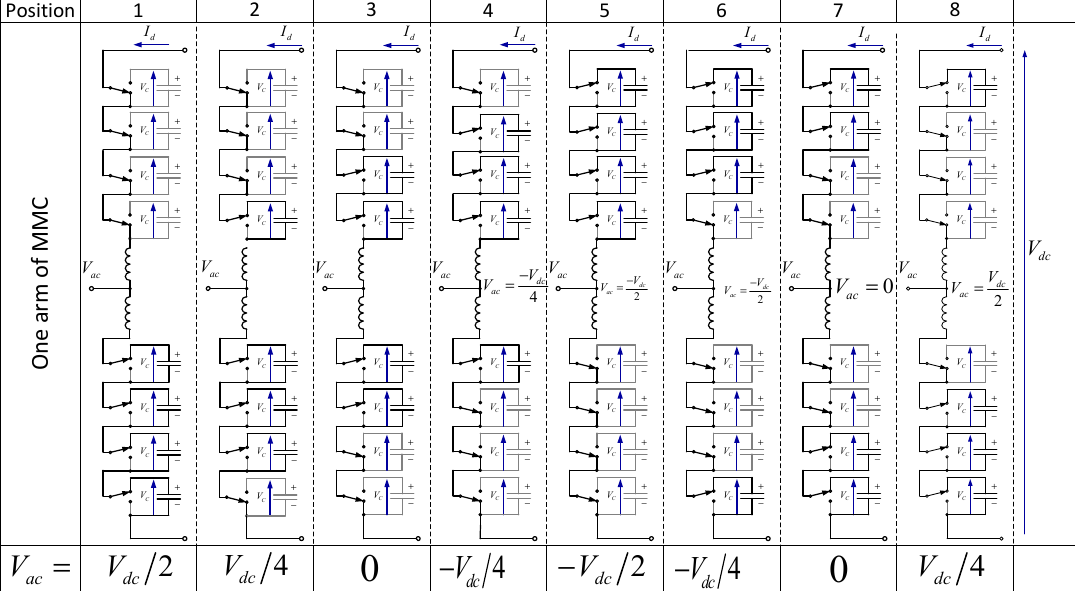
Figure 24. Output voltage (fundamental frequency switching).